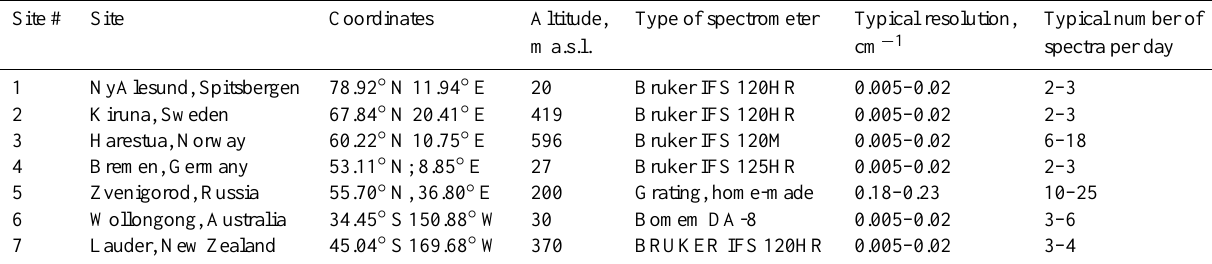
Table 2. Characteristics of ground-based sites and spectrometers used in this study. Site # Site